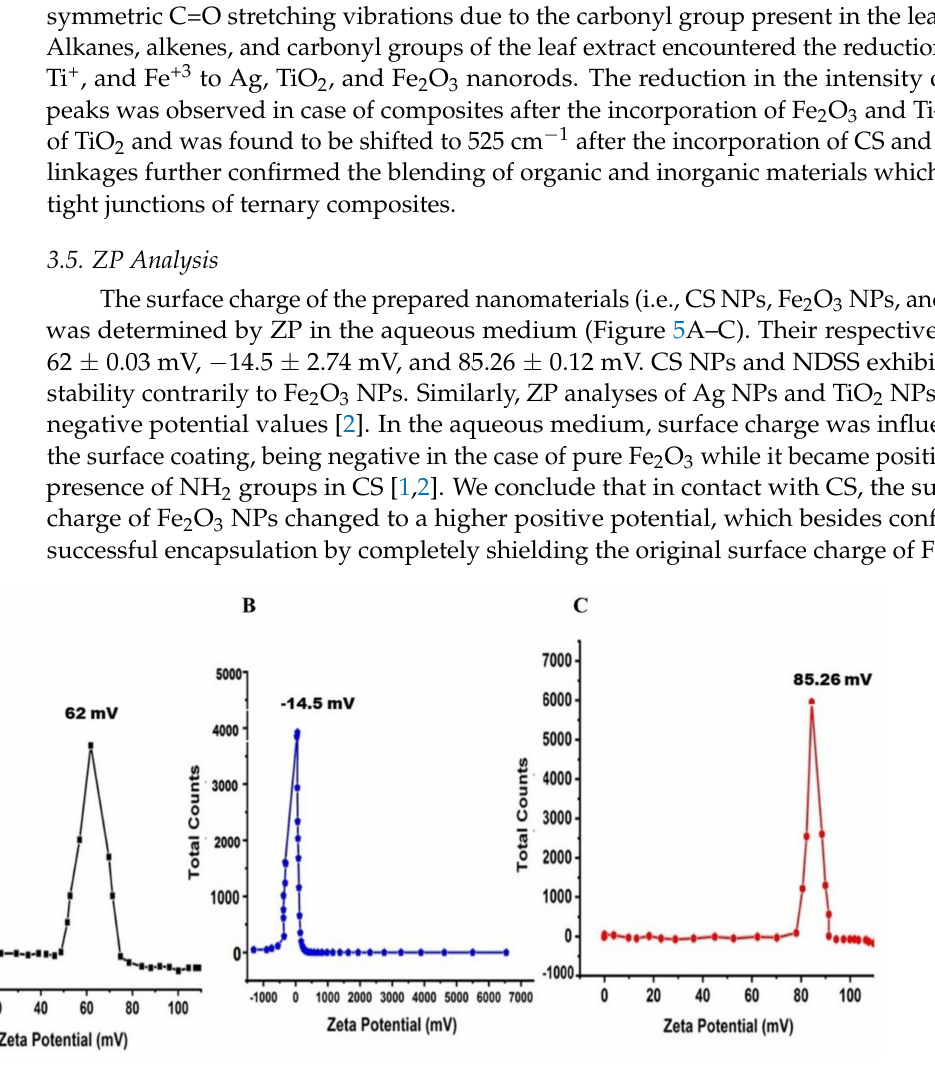
Figure 5. Zeta potential analysis of synthesized nanomaterials. ( A ) CS NPs; ( B ) Fe 2 O 3 NPs; ( C ) CIP- Ag/TiO 2 /Fe 2 O 3 /CS nanoformulation